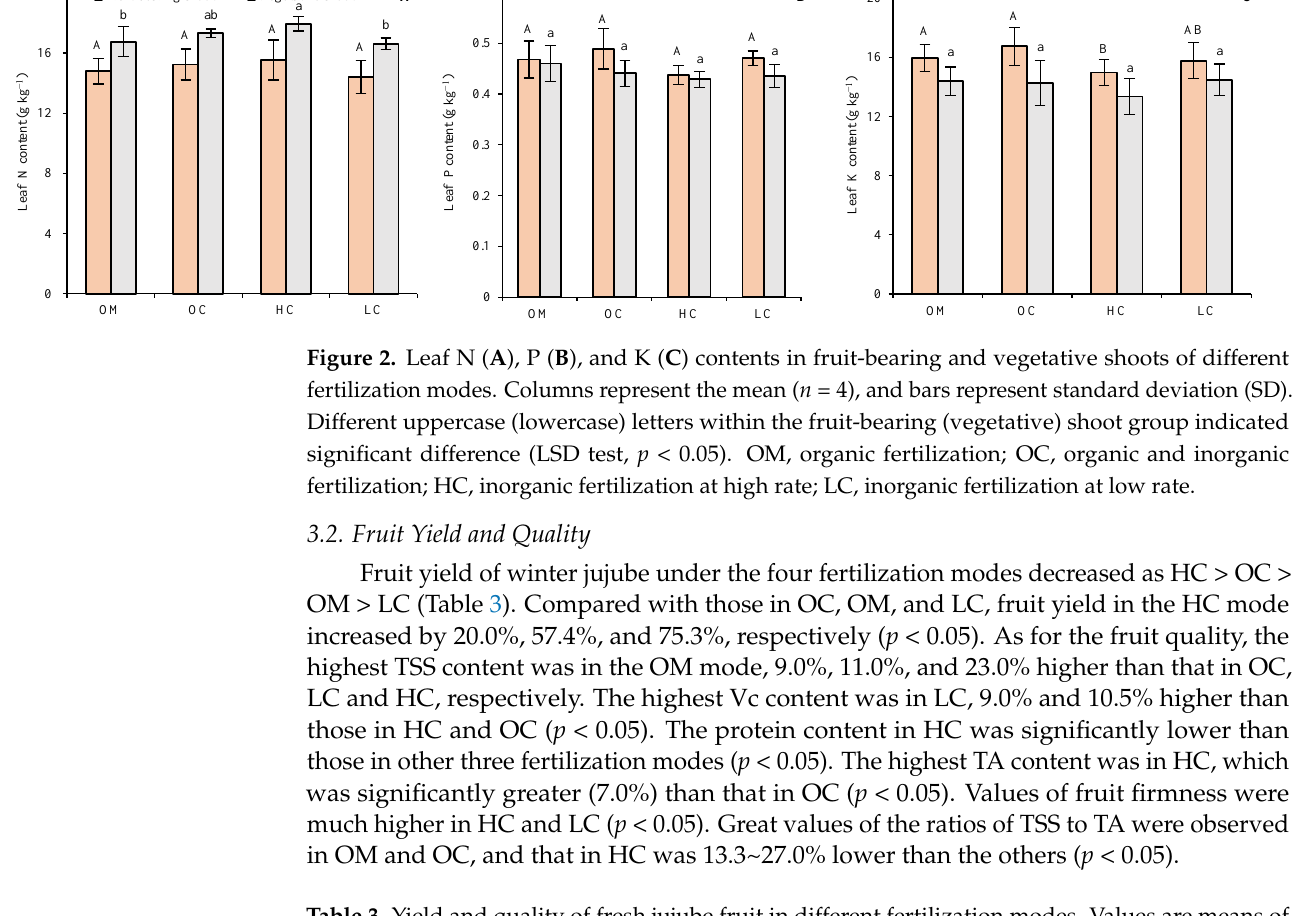
Table 3. Yield and quality of fresh jujube fruit in different fertilization modes. Values are means of the average of four jujube orchards using same fertilization mode ( n = 4). Different letters in each column indicated significant difference (LSD test, p < 0.05).